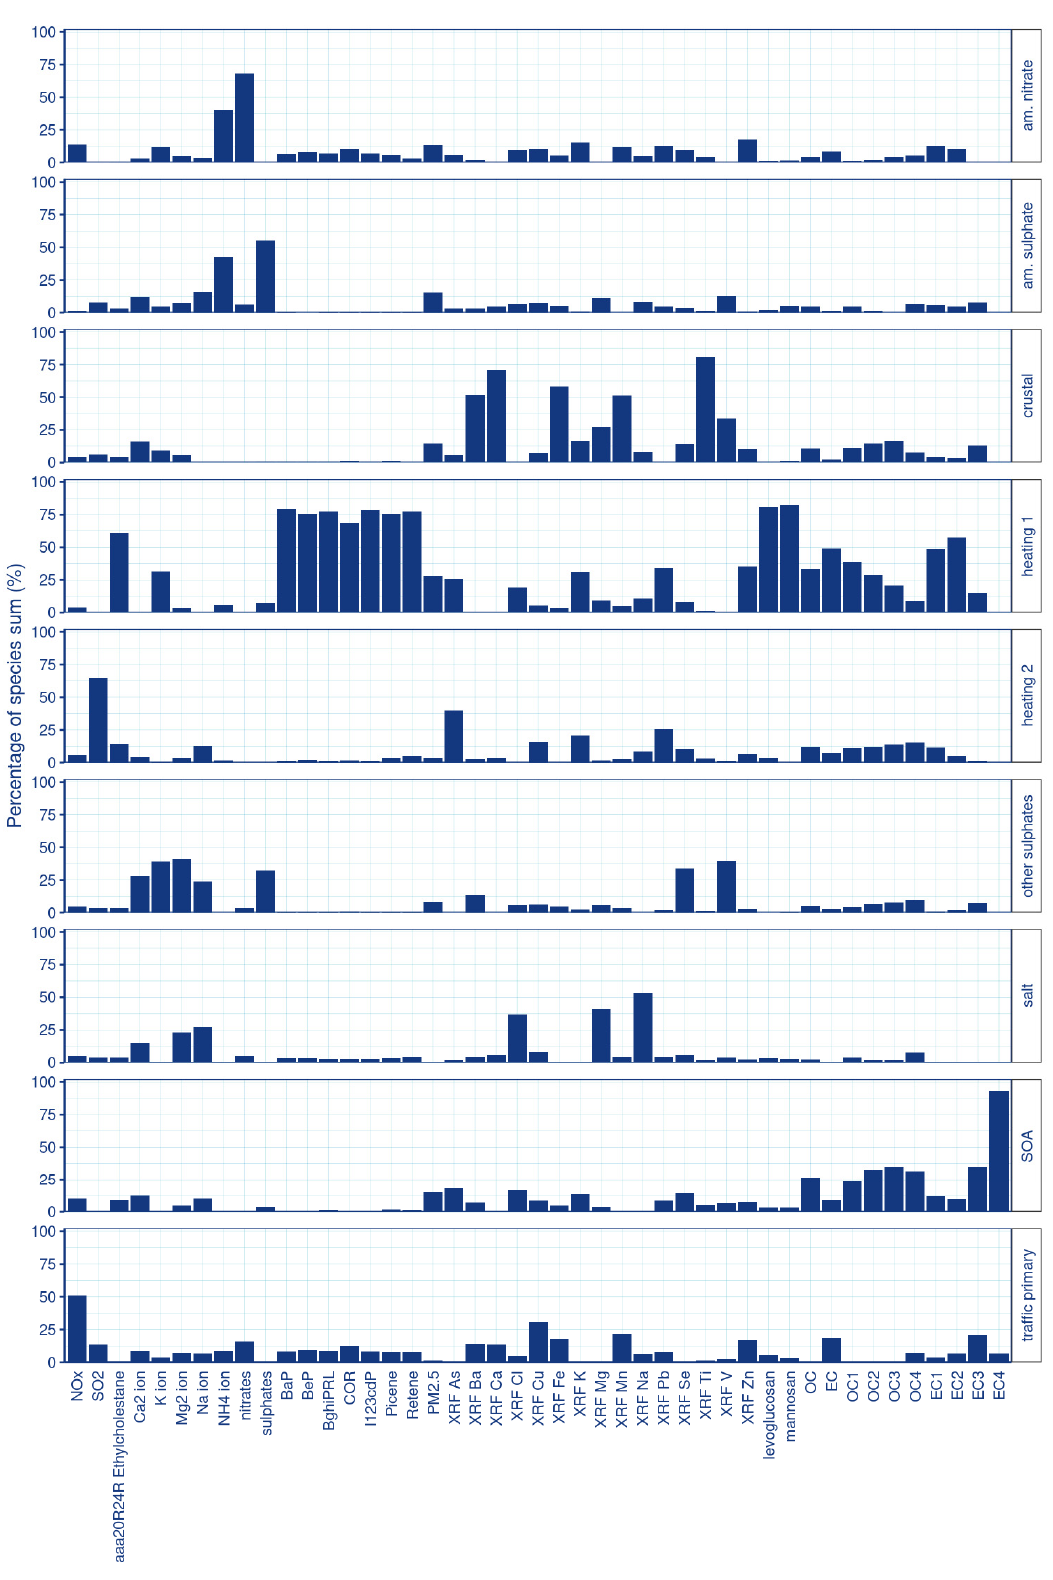
Figure A1. Percentage of species sum in factor profiles.